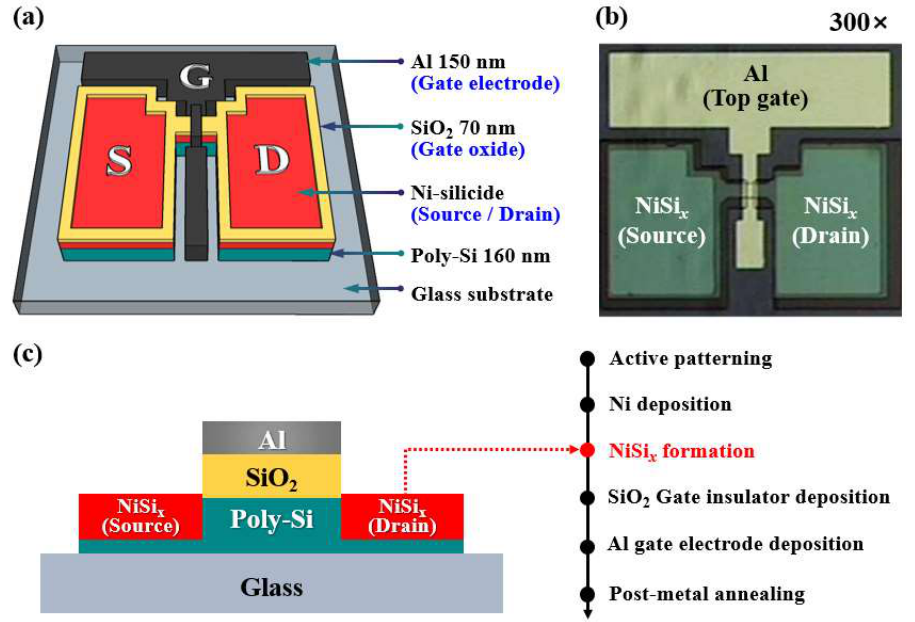
Figure 3. The schematic structure (a) , top-view optical microscope image (b) , and cross-sectional structure and process flow (c) of the fabricated NiSi x SB-TFTs.